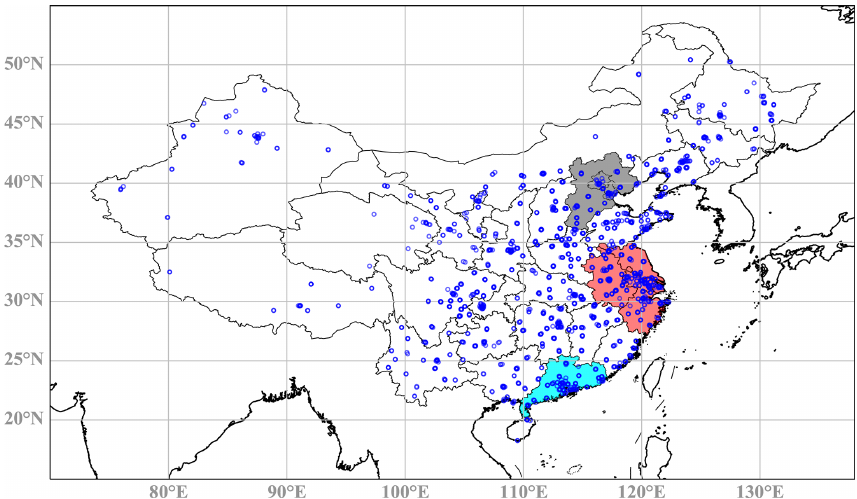
Figure 1. Location of the MEE network stations as of 2019. Blue circles represent the MEE stations. The three metropolitan regions that we focused on in the analysis are shaded in grey, red, and cyan, for Jing-Jin-Ji (JJJ), the Yangtze River Delta (YRD), and the Pearl River Delta (PRD),